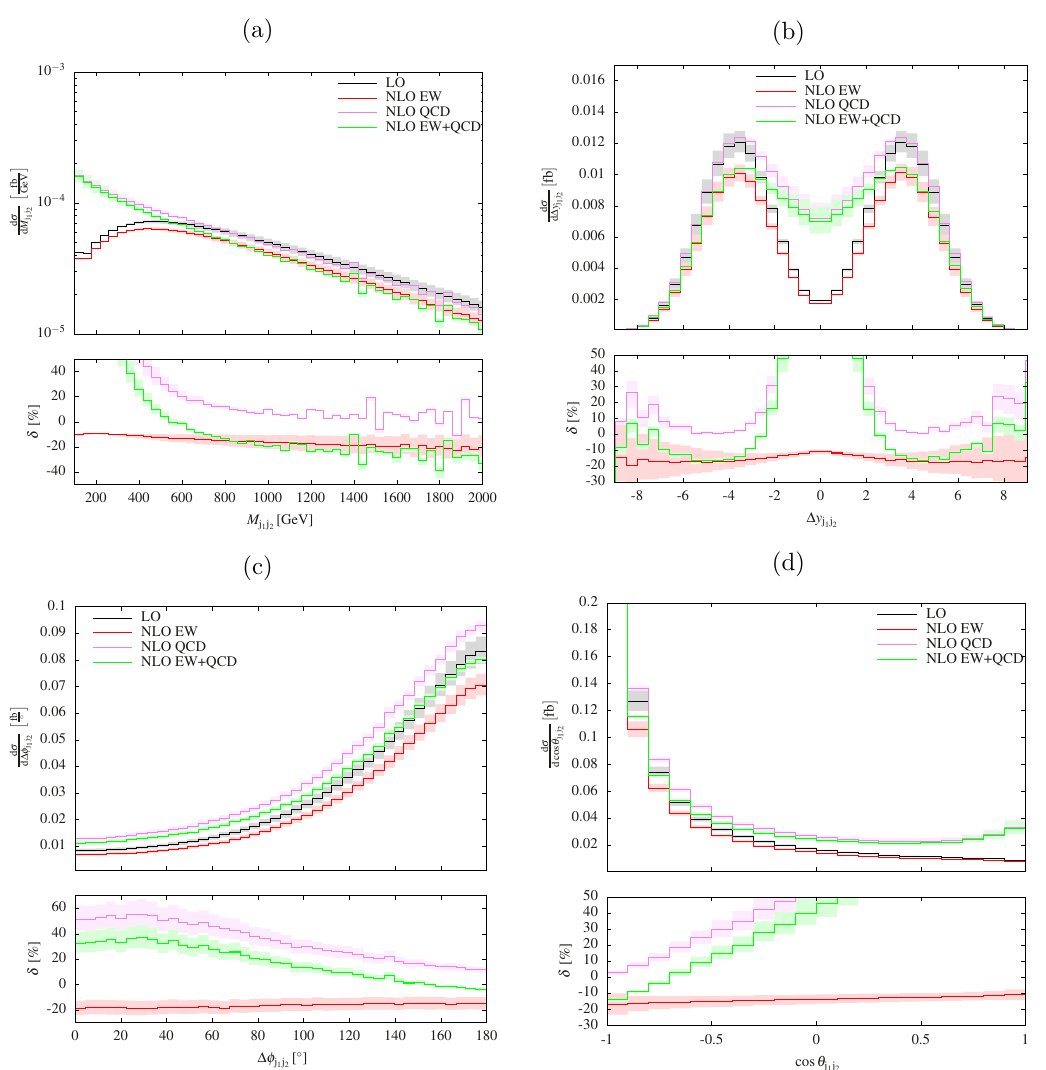
(cid:0) (cid:1) (cid:0) (cid:1) α 6 (LO), O α 7 (NLO EW),